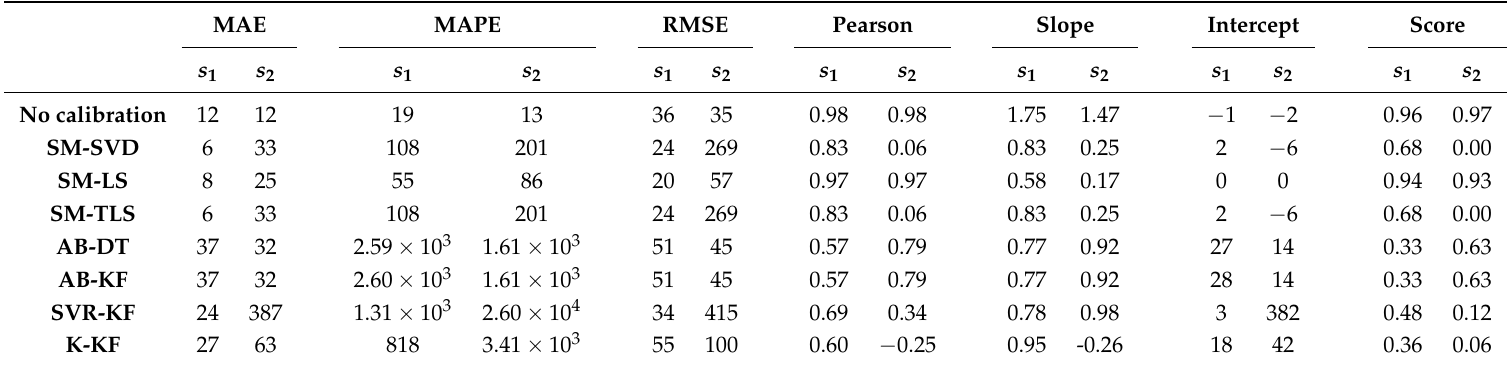
Table 8. Values of the metrics, computed on the entire time interval of drift, for two particular sensors of the network s 1 = 2 and s 2 = 10, with the Gaussian plume model. No calibration strategy allows to obtain less error than without calibration, even for SM-(SVD, LS, TLS) strategies that had the best performances in Section 4, despite apparently satisfying results according to MAE but not according to the slope and intercept